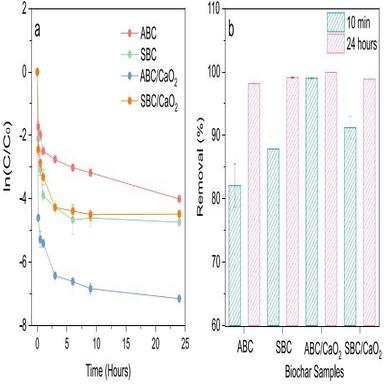
The performance of tebuconazole removal using different kinds of biochars. a) Tebuconazole removal kinetics for 24 h. b) The removal efficiency of tebuconazole in the solution after 10 min and 24 h.